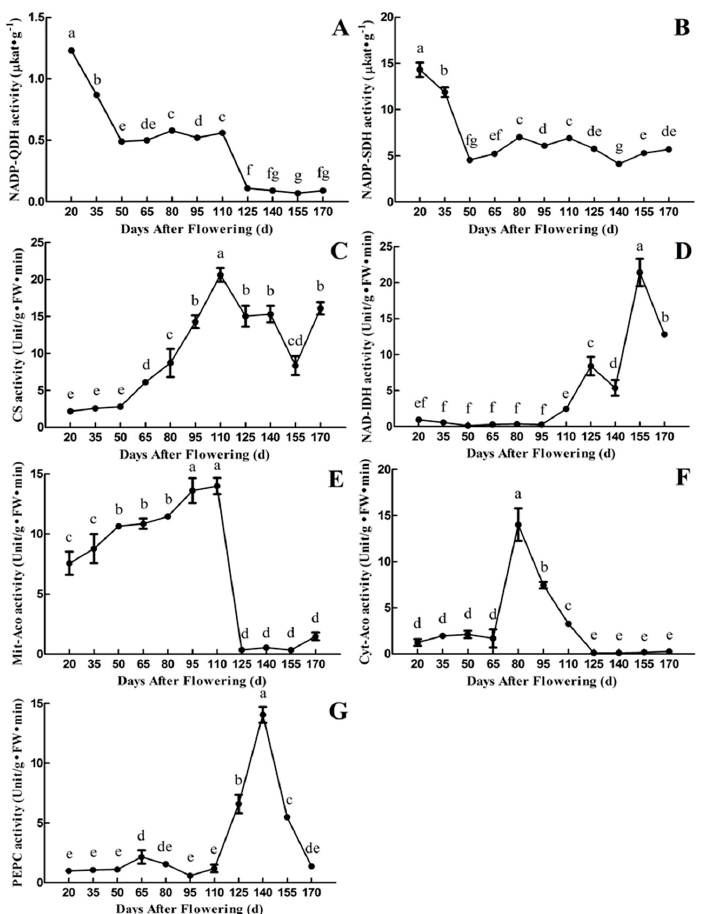
Figure 4. Changes in the activities of quinic acid and citric acid-related enzyme during fruit development and maturation of A. eriantha ‘Ganmi 6’, including NADP-QDH ( A ), NADP-SDH ( B ), CS ( C ), NAD-IDH ( D ), Mit-Aco ( E ), Cyt-Aco ( F ), and PEPC ( G ). FW: Fresh weight; NADP-QDH: NADP-Quinate dehydrogenase; NADP-SDH: NADP-Shikimate dehydrogenase; CS: Citrate synthase; NAD-IDH: NAD-Isocitrate dehydrogenase; Mit-Aco: Mitochondrial aconitase; Cyt-Aco: Cytoplasmic aconitase; PEPC: Phosphoenolpyruvate carboxylase. Data are means ± standard deviations of three biological repetitions. Error bars represent standard deviations of means. Different lowercase letters are significantly different at p < 0.01. Data were analyzed with two-way analysis of variance (ANOVA) and Duncan’s multiple range tests.